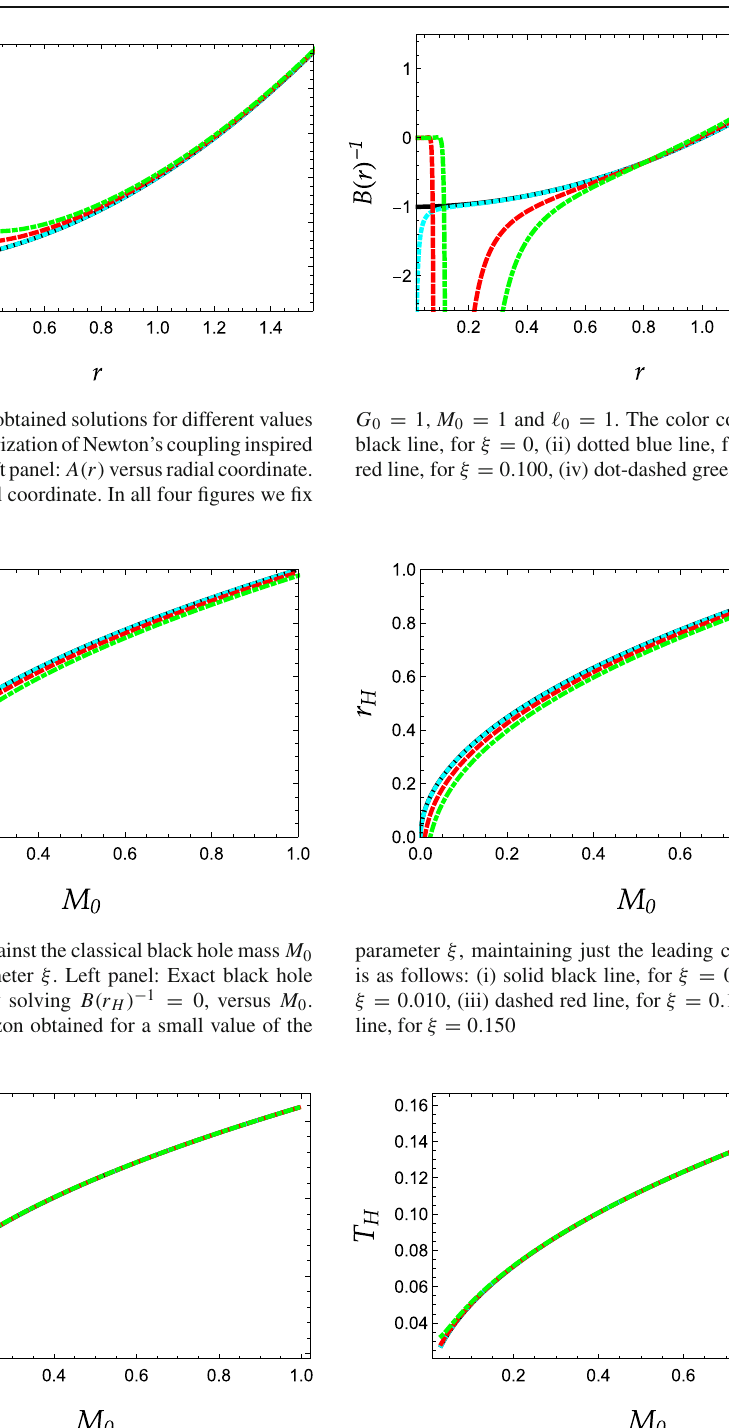
value of the parameter ξ , maintaining just the leading correction (using Eq. (37)). The color code is as follows: (i) solid black line, for ξ = 0, (ii) dotted blue line, for ξ = 0 . 010, (iii) dashed red line, for ξ = 0 . 100, (iv) dot-dashed green line, for ξ = 0 .